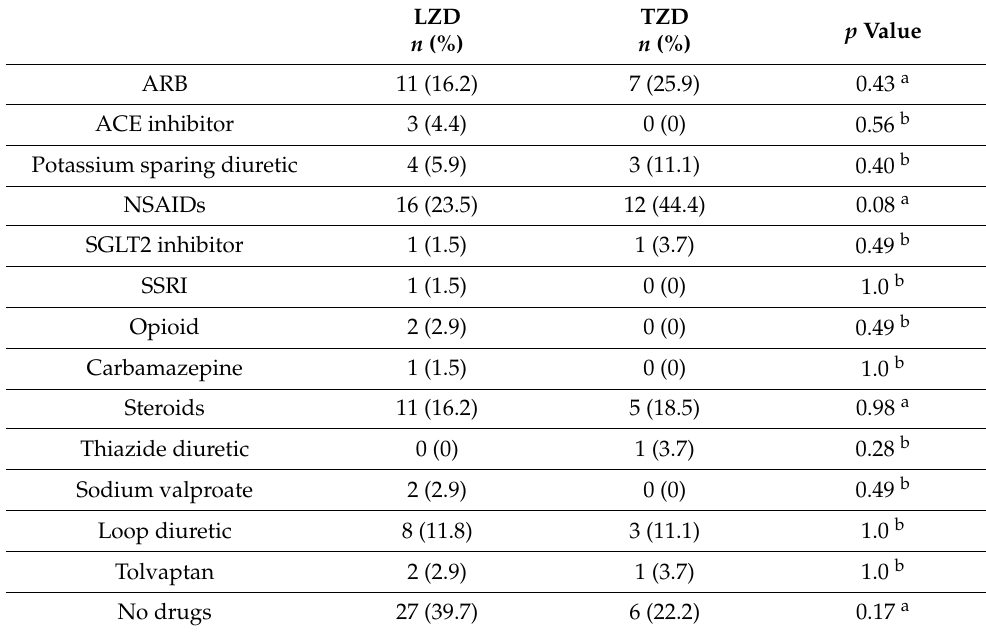
Table 4. Concomitant drugs that may influence serum sodium